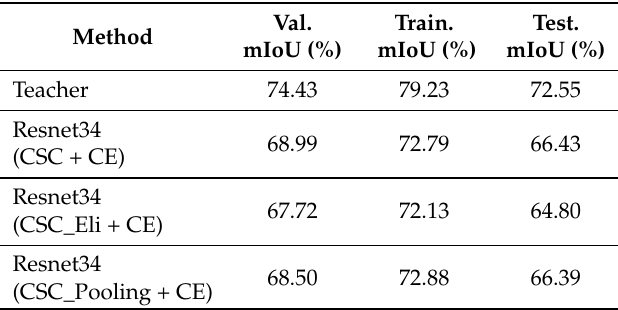
Table 2. Effects of the number of channels in the feature map.